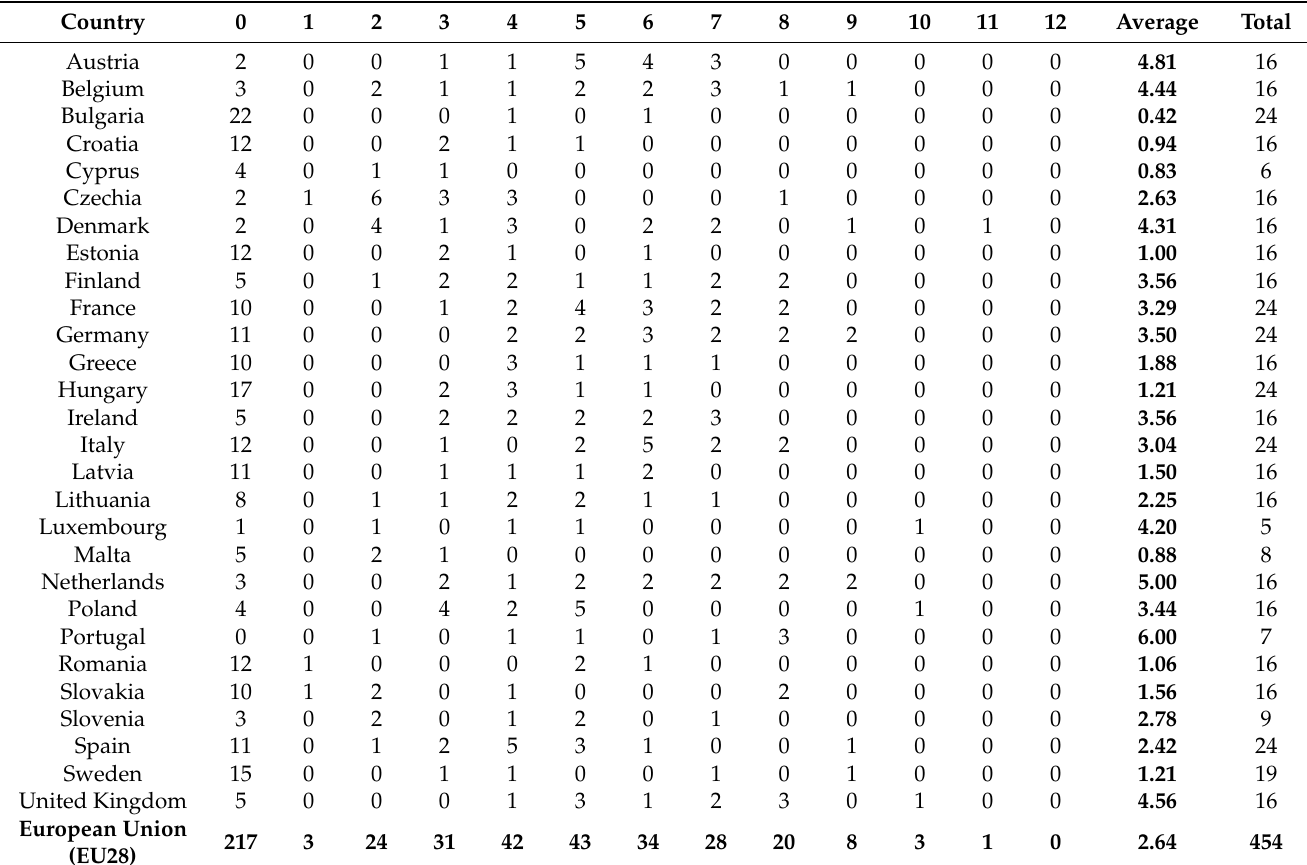
Table 5. “Level of digitization” * for European agri-food cooperatives EU (28). 2018–2019. Source: Own